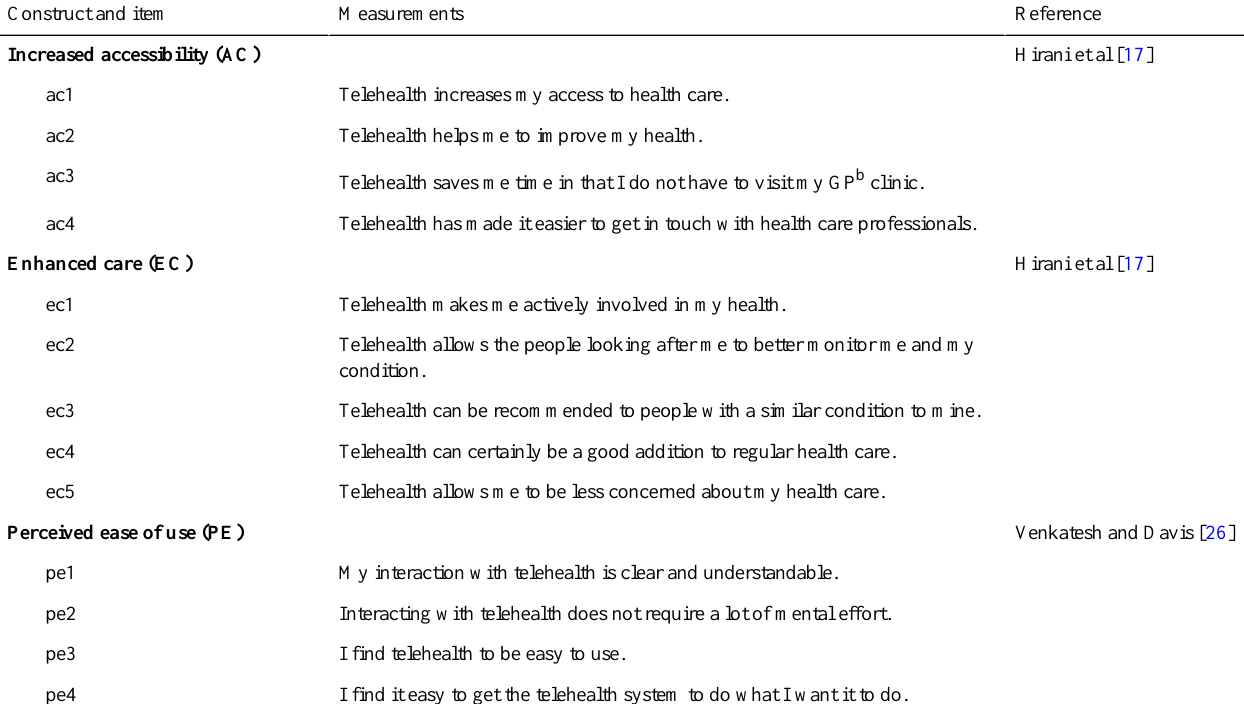
Table 1. Measurement items of constructs a . ReferenceMeasurementsConstruct and item